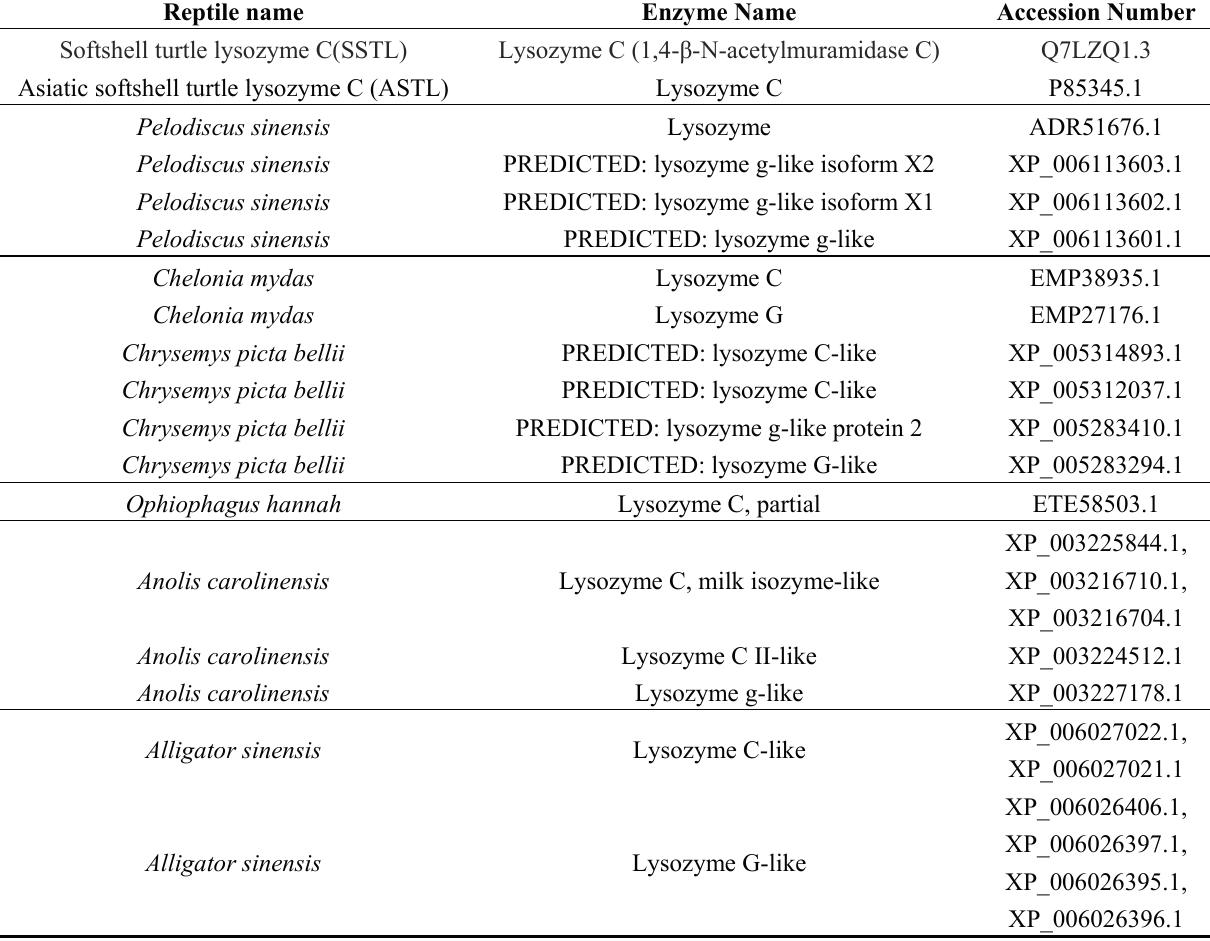
Table 8. Selected predicted lysozyme genes identified in reptiles.